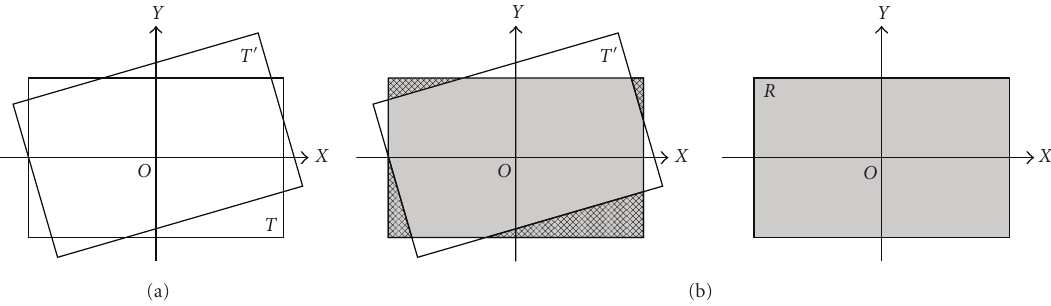
Figure 3: Two steps in image registration: (a) rigid-body transformation on the test image T , (b) calculate correlation coe ffi cient between the transformed test image T (cid:2) and the reference image R .